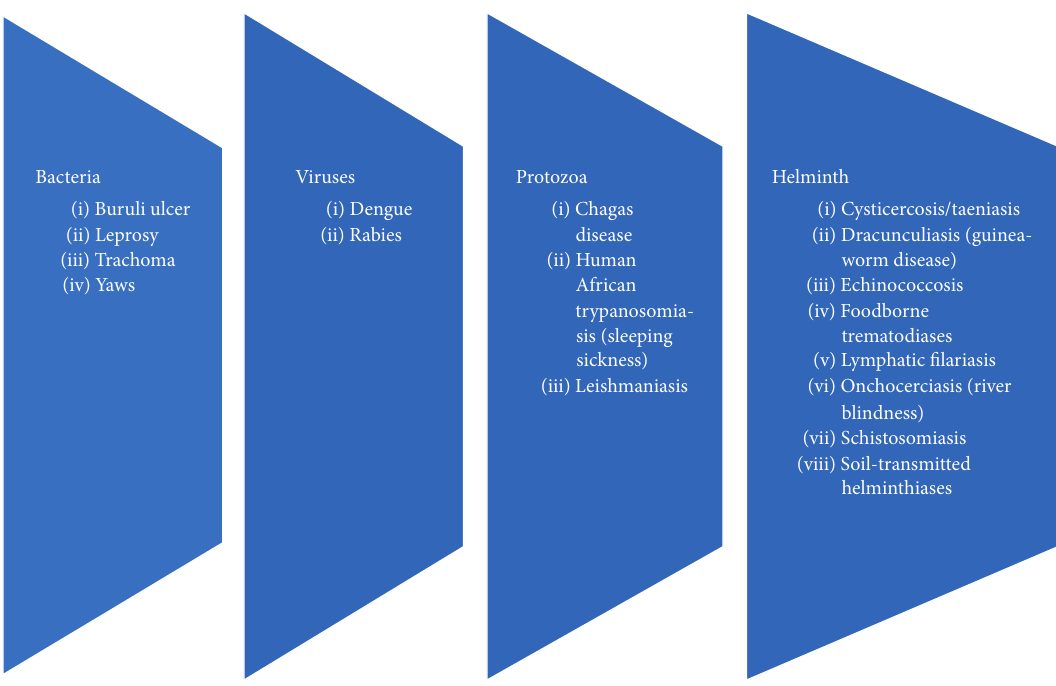
Figure 1: Diseases included in neglected tropical diseases (NTD) by WHO according to the causative agents.